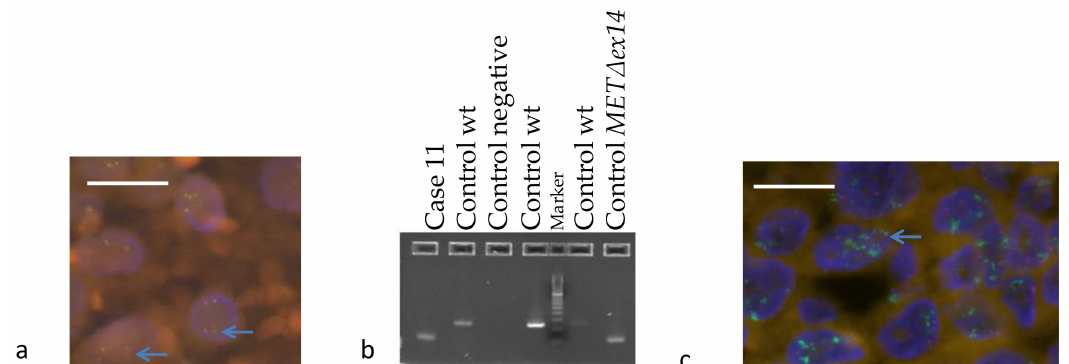
Figure 4. ( a ) Fluorescence in situ hybridization analysis for ALK in sample 10, blue arrows indicate translocated signals; ( b ) Visualization by agarose gel of the PCR band corresponding to the MET ∆ ex14 splicing variant in sample 11. The upper band corresponds to the amplification of the wt region. ( c ) Fluorescence in situ hybridization analysis for MET in sample 7, blue arrows indicate amplified cells. The scale bars correspond to 20 µ